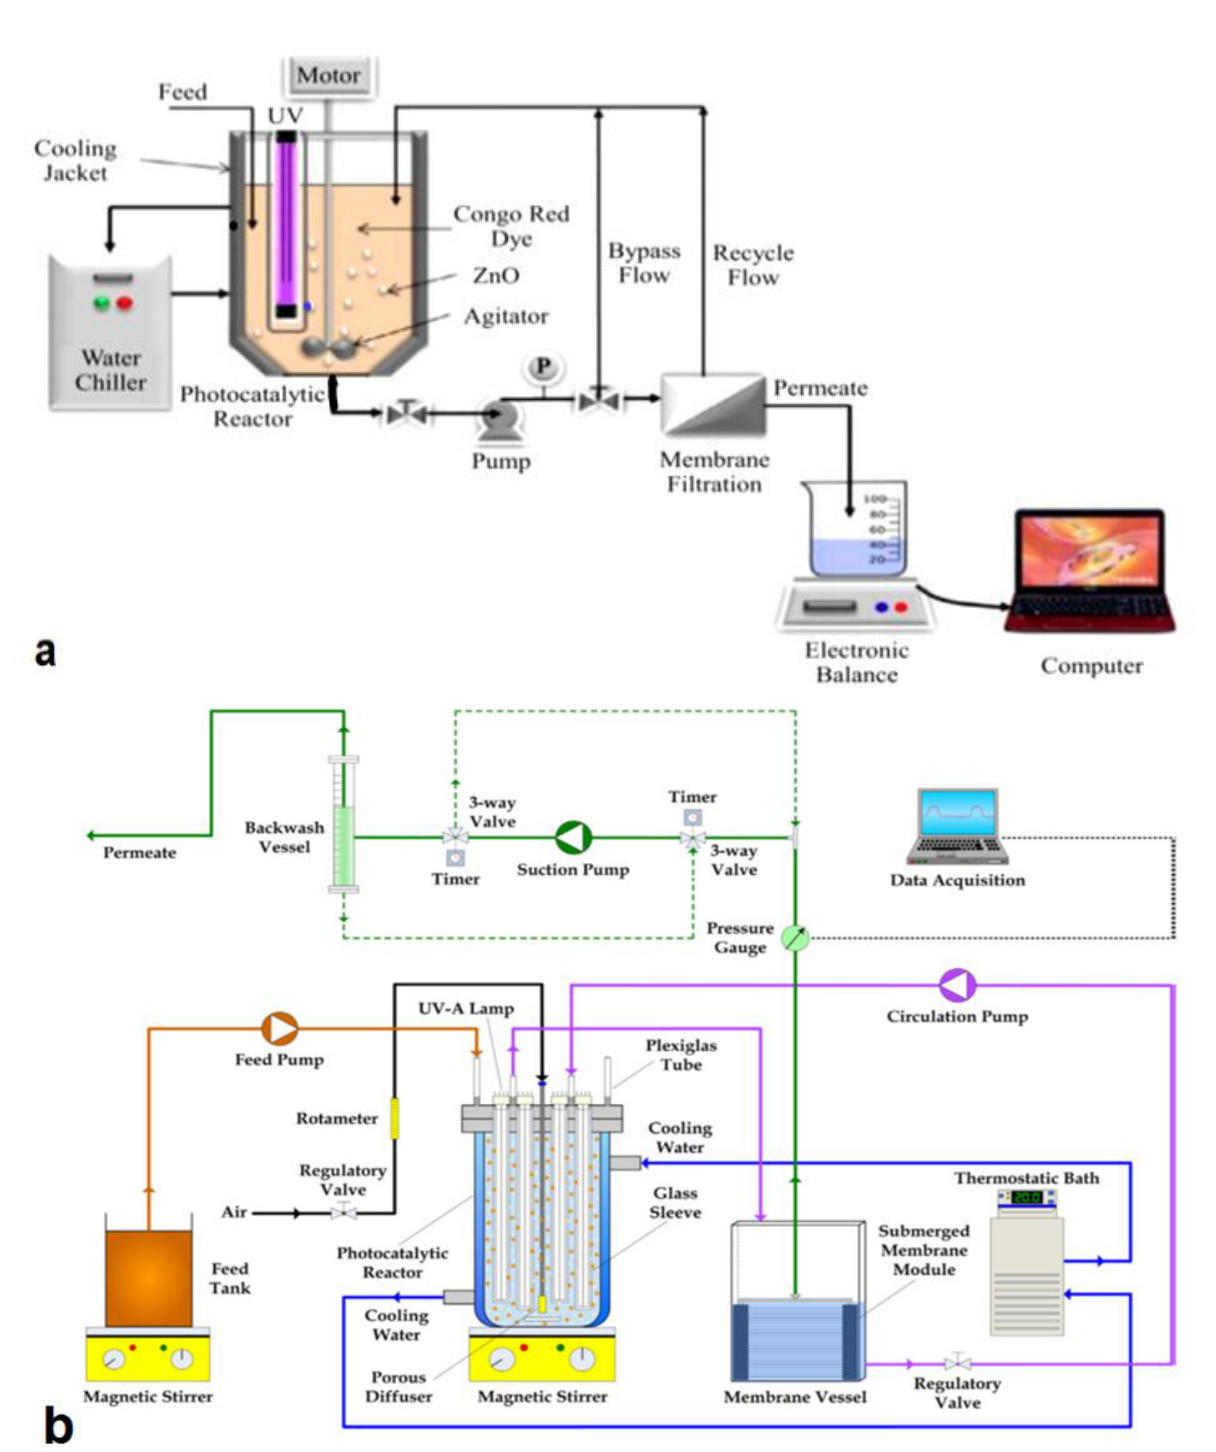
Figure 2. Schematic diagram of a typical split-type PMR ( a ) with suspended ZnO for degrading Congo red dye from wastewater, reproduced with permission from [11], Copyright 2014 Elsevier; and ( b ) a laboratory pilot system for the degradation of diclofenac in wastewater, reproduced with permission from [59], Copyright 2014 Elsevier.